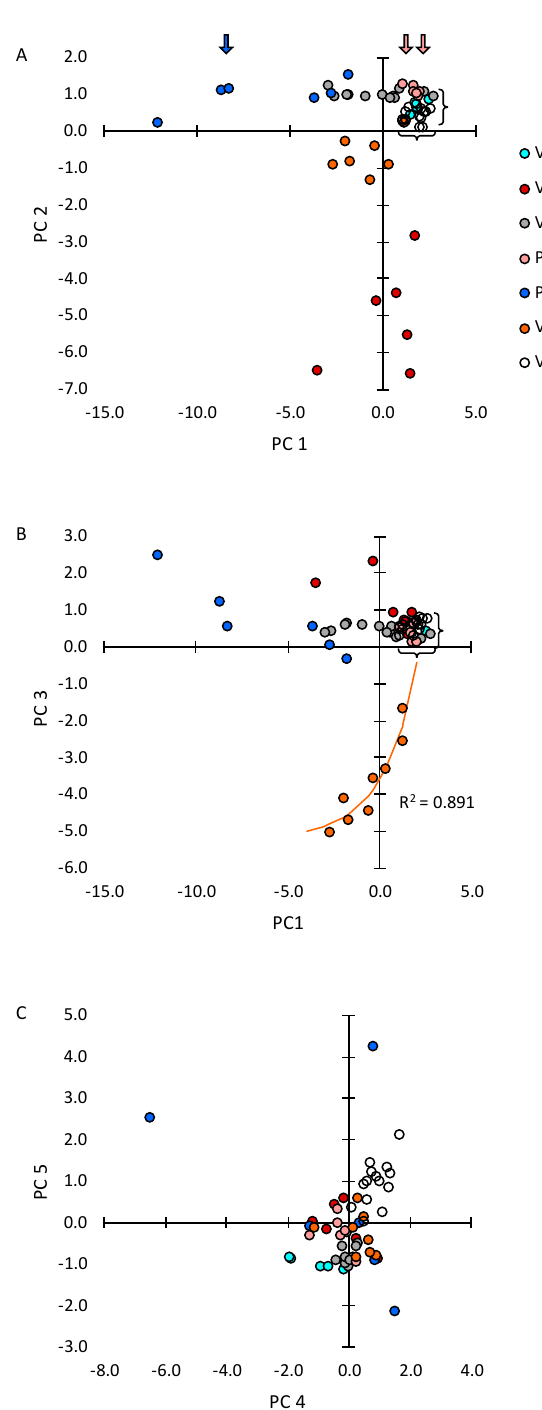
Figure 2. Principal component (PC) projections of individual glands from all groups determined by principal component analysis of the collated abundances of 20 transcripts that were assayed in all whole-gland samples. ( A ) PC2 v PC1; ( B ) P3 v PC1; ( C ) PC5 v PC4. A total of 72 transcripts were assayed in whole-gland samples from groups V.G5 and P.G5 [49]. Discrepancies between principal component values from that dataset and the collated dataset resulted primarily from the data from groups V.G2 and V.G6. Arrows indicate PC1 projections of glands that were selected for microdissection.